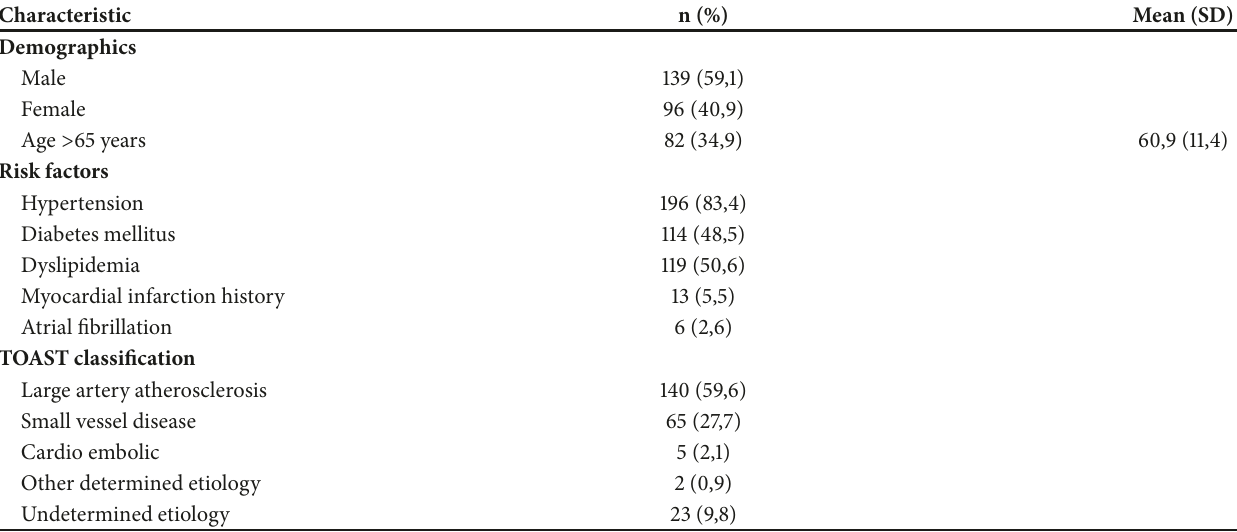
Table 1: Characteristics of the subjects (n=235).